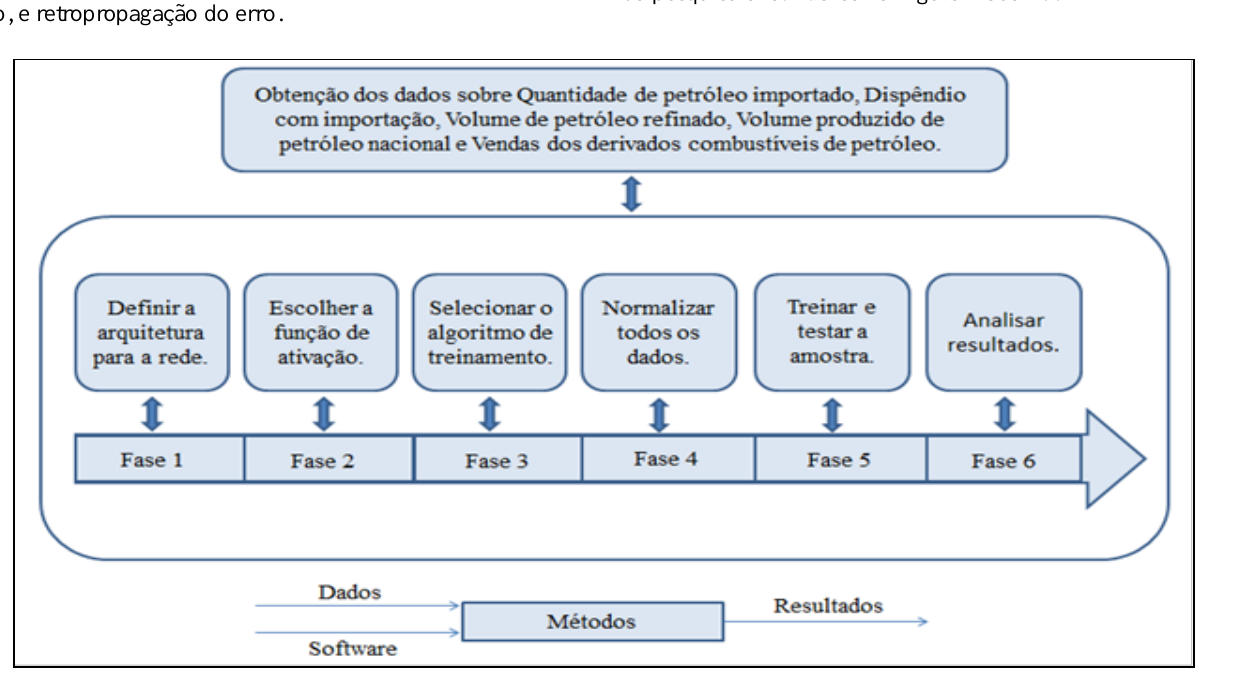
Figura 2: Fases do processo de elaboração da pesquisa. Fonte: Autores, (2017).